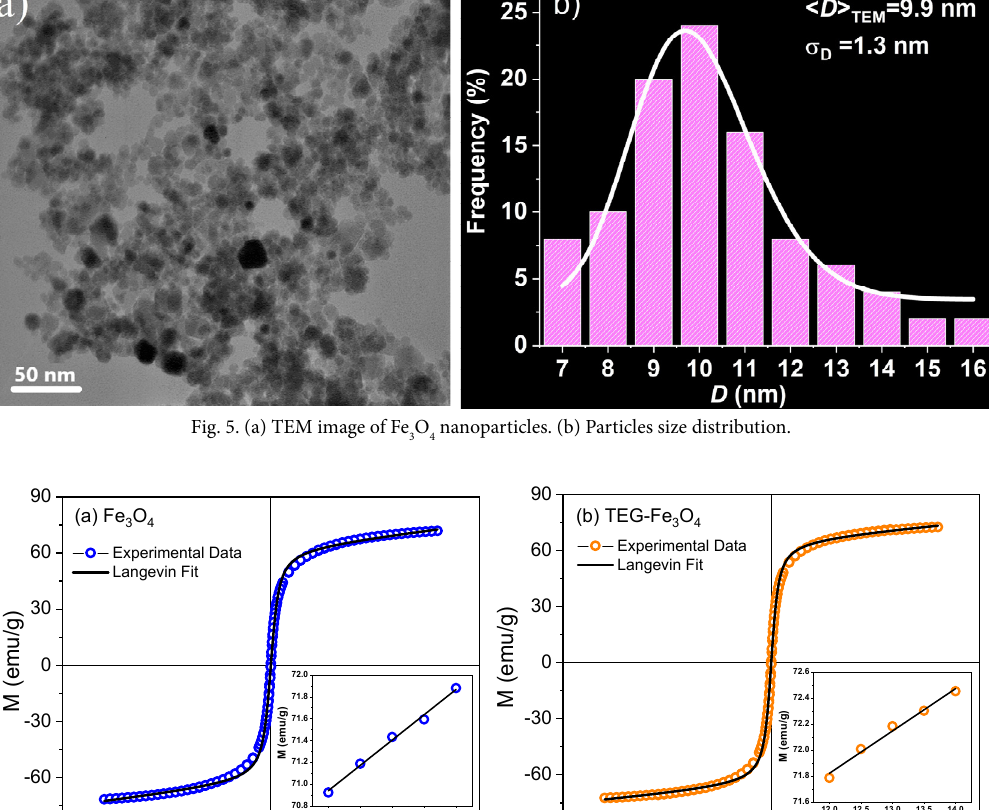
O and (b) TEG-Fe O samples. Hollow symbols show experimental data, and solid lines are 3 4 3 4